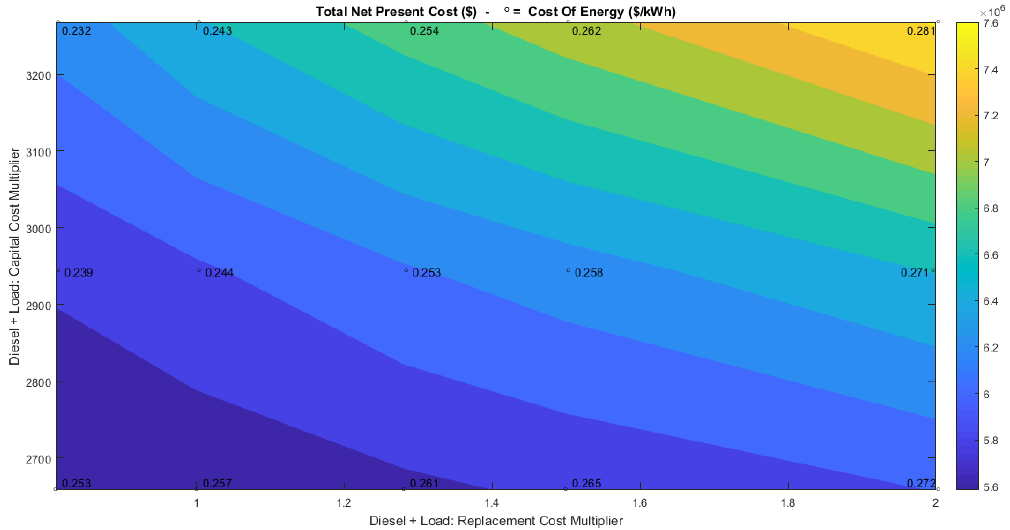
Figure 10. Effect on varying electric load and diesel fuel price on the COE and the NPC superimposed COE–surface NPC.